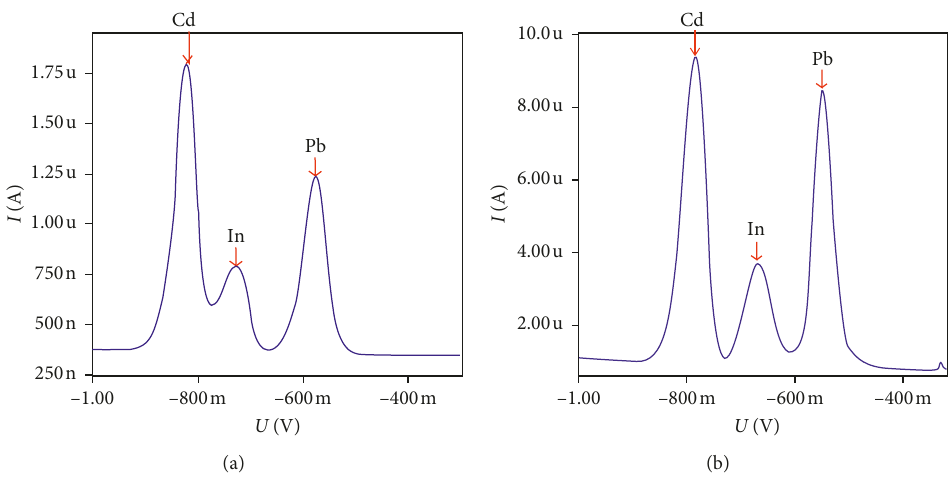
Figure 6: DP-ASV of Cd, Pb, and In supporting electrolytes: (a) acetate buffer (pH � 4.5); (b) mixture of 0.1M KI and acetate buffer (pH 4.5). Conditions: [Cd(II)] � 5 μ g · L − 1 ; [Pb(II)] � 5 μ g · L − 1 ; [In(III)] � 10 μ g · L − 1 . Other conditions are as in Figure